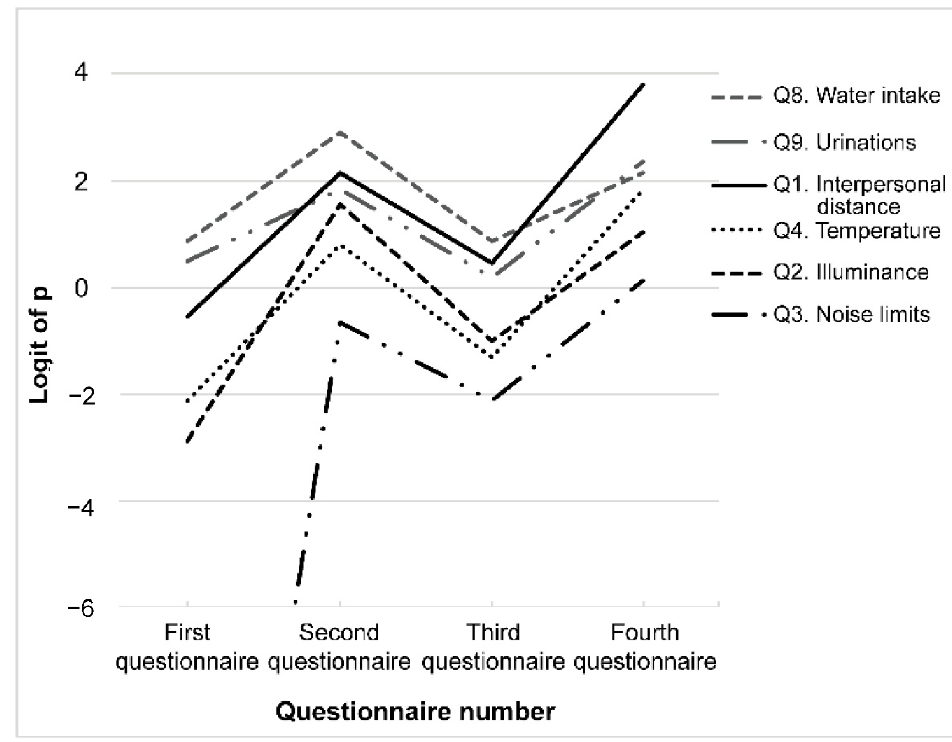
Figure 3. Pattern #1: Correct answer rate improves after the first class. Questions with an estimated correct answer rate of “second > first” were selected. Each question is indicated using a different